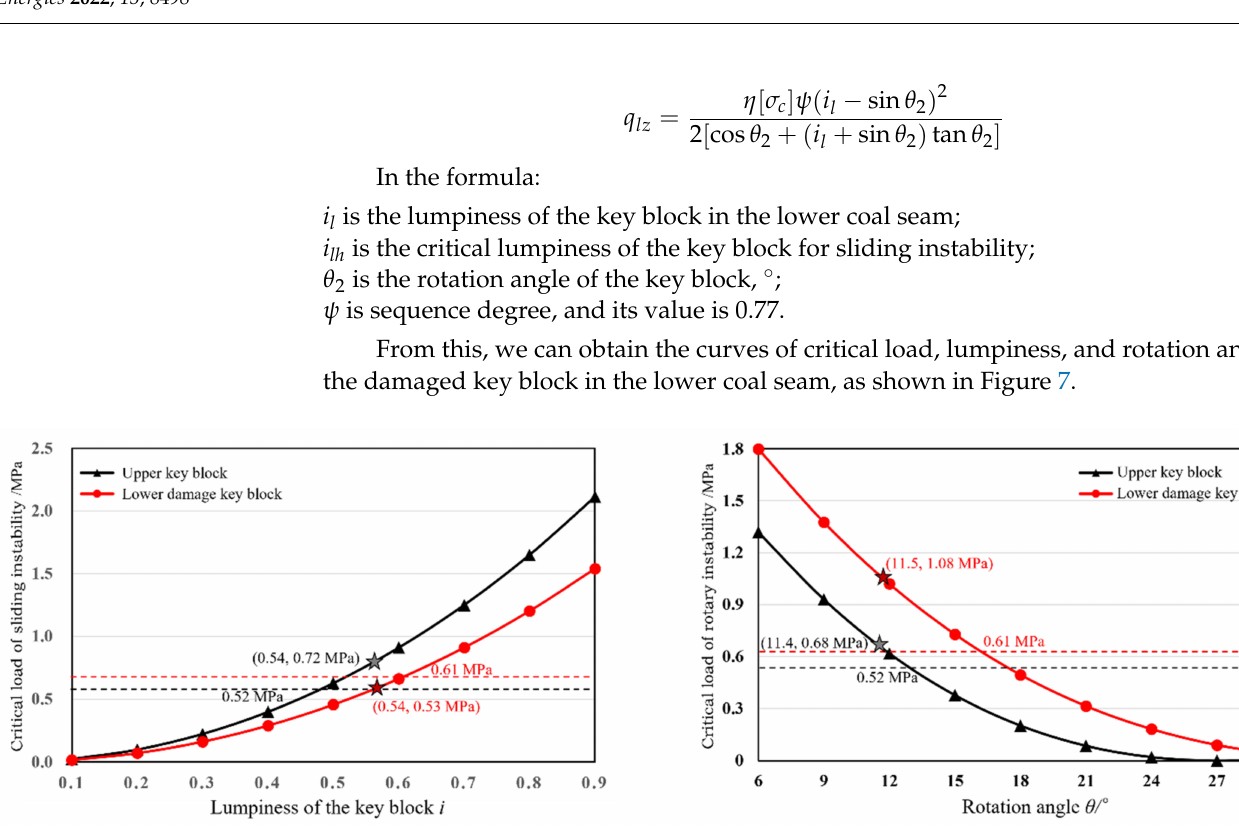
Figure 7. Linkage analysis of upper and lower main roof key